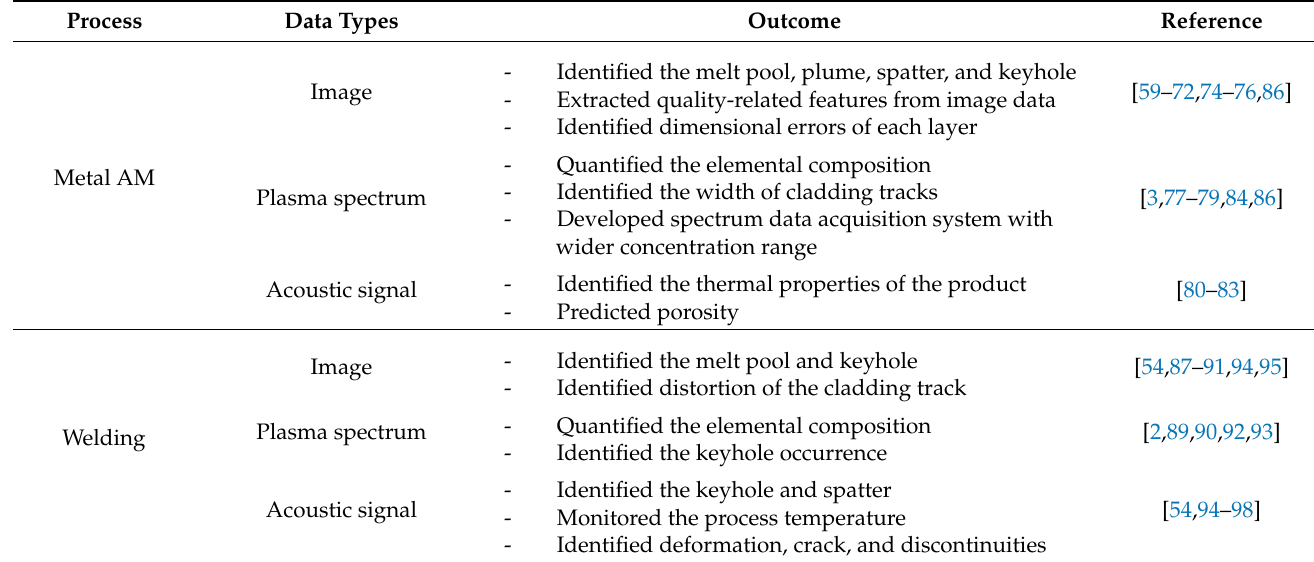
Table 2. Classification for experimental quality control studies of metal AM and welding by utilized data. Process Data Types Outcome